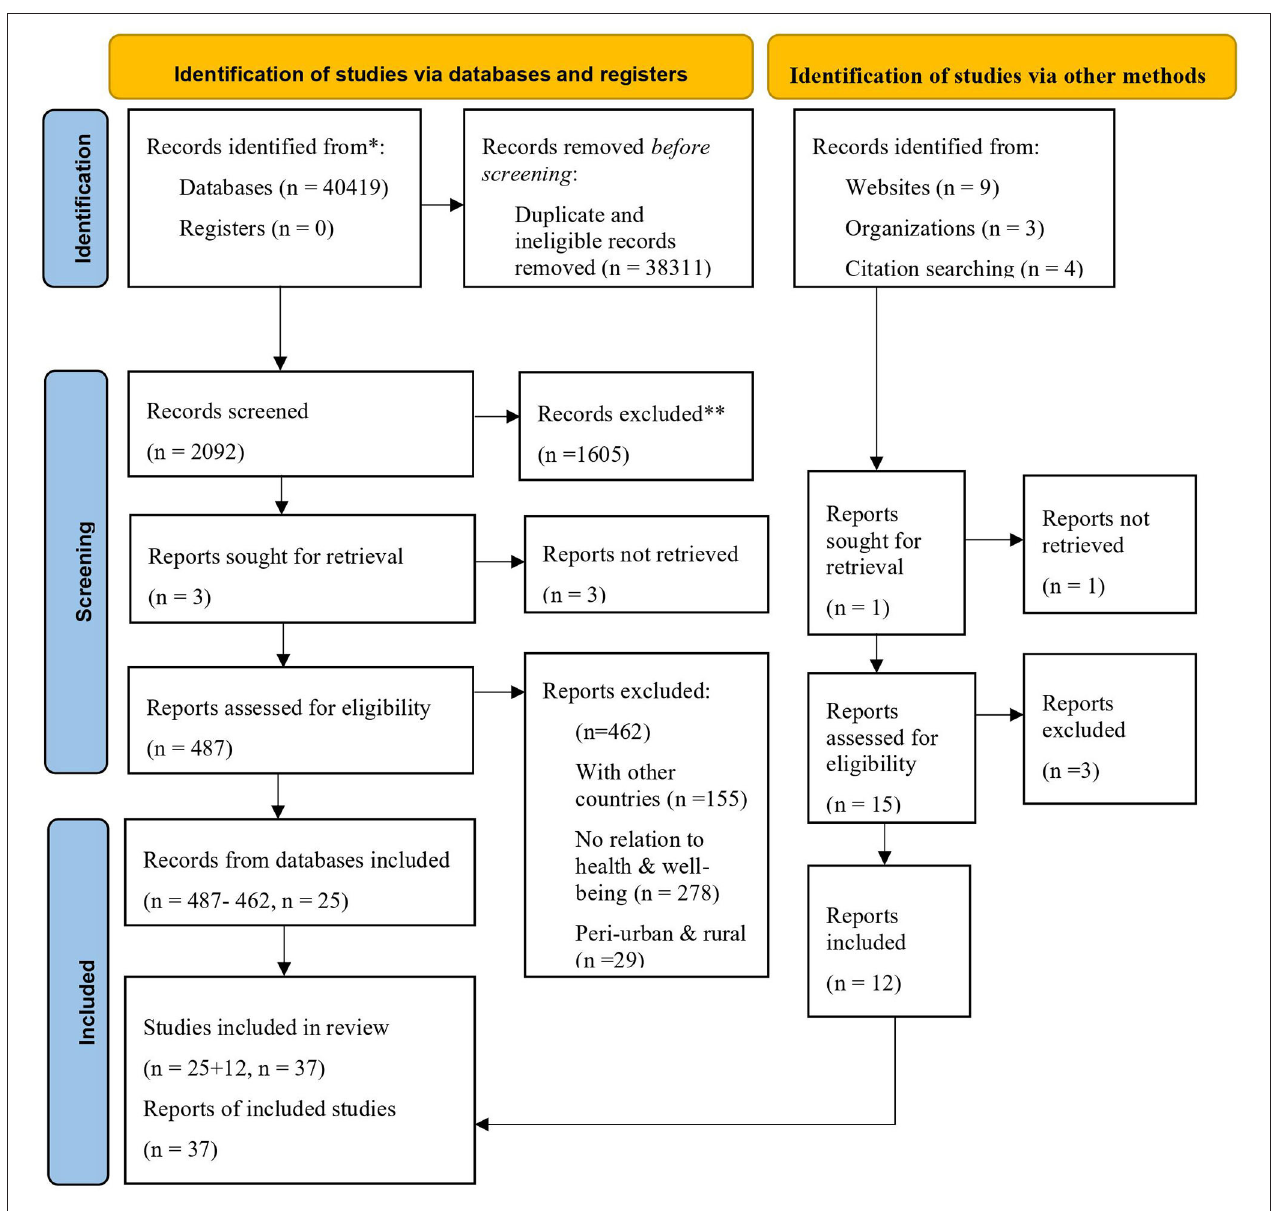
FIGURE 1 | PRISMA flow chart of